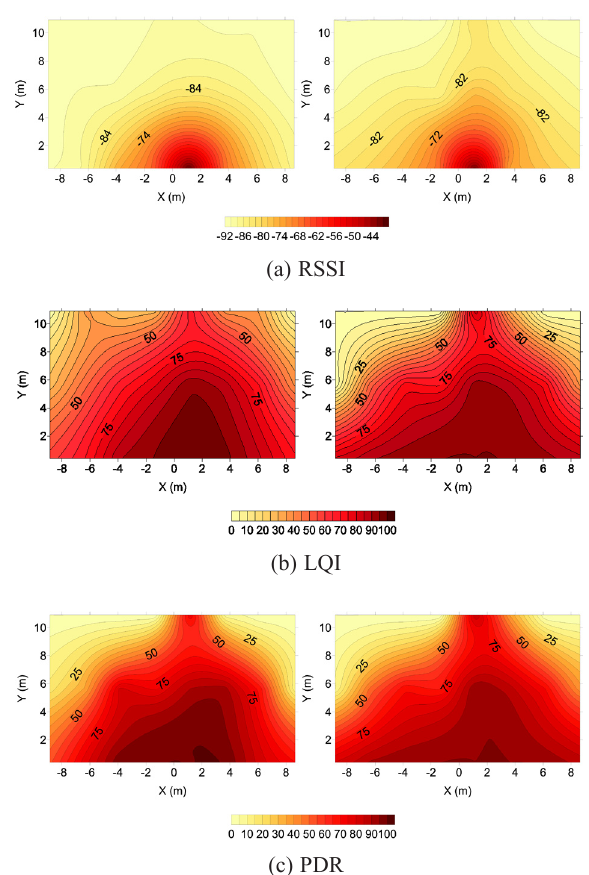
Fig. 6. Contour map for concrete girder bridge with BS at center (left: measured and right: